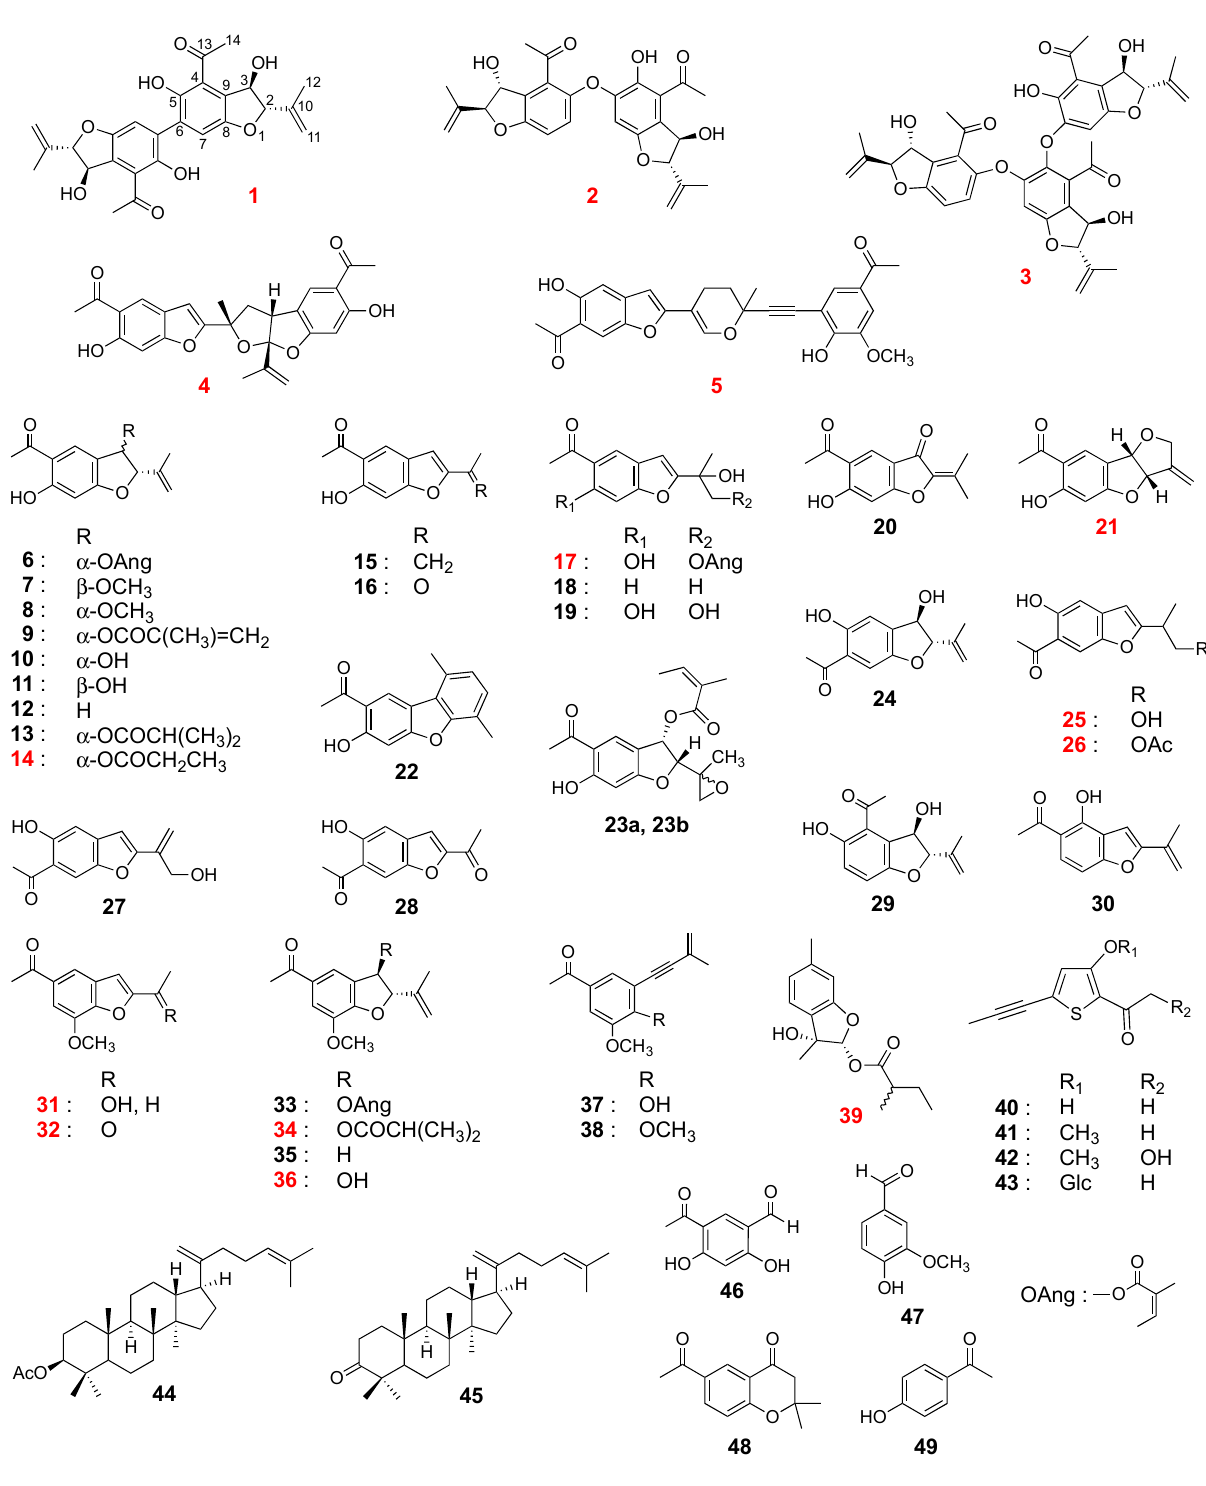
Figure 9. Compounds isolated from the roots of E. heterophyllum (new compounds shown in red).